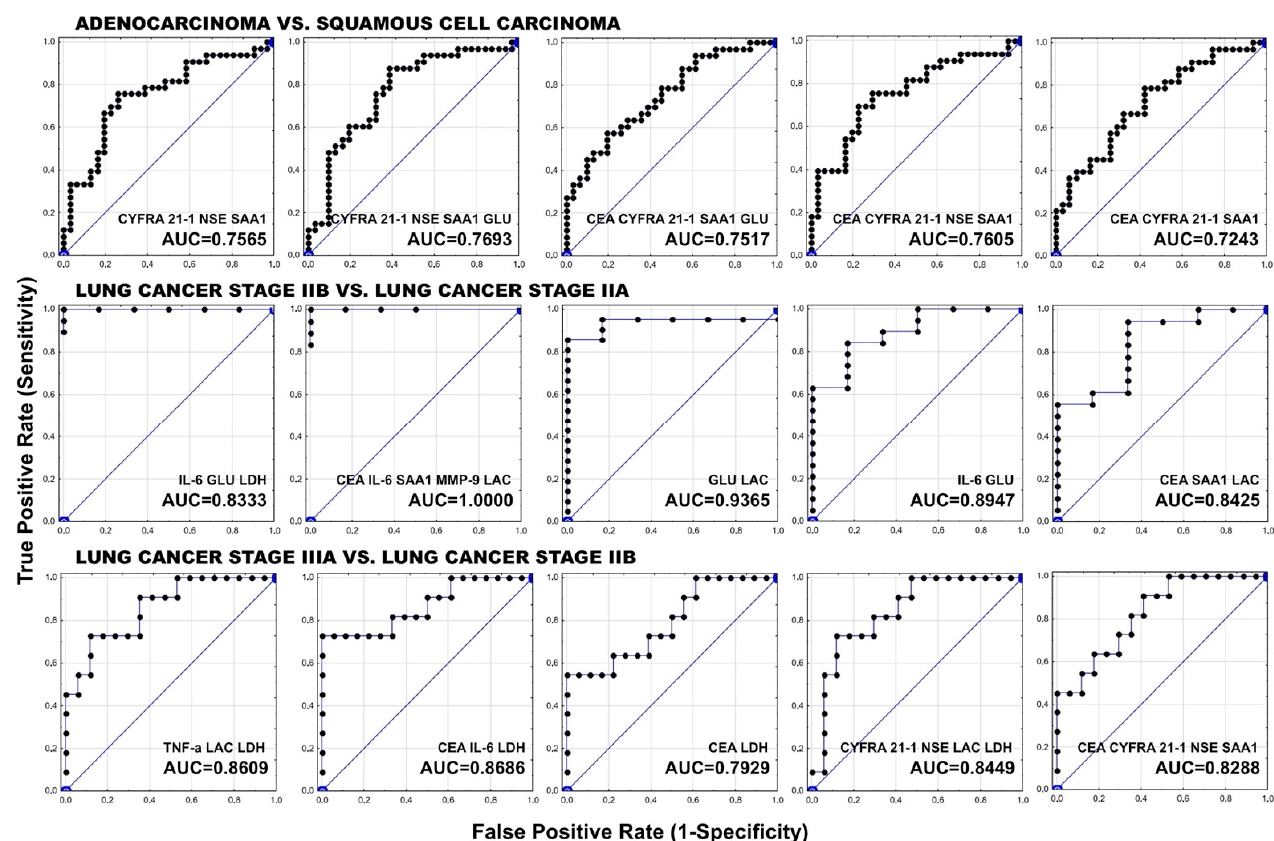
Figure 7. Receiver operating characteristic (ROC) curves evaluating the ability of multi-biomarker models to distinguish NSCLC patients with adenocarcinoma and squamous cell carcinoma, lung cancer stage IIB and IIA, and IIIA and IIB.